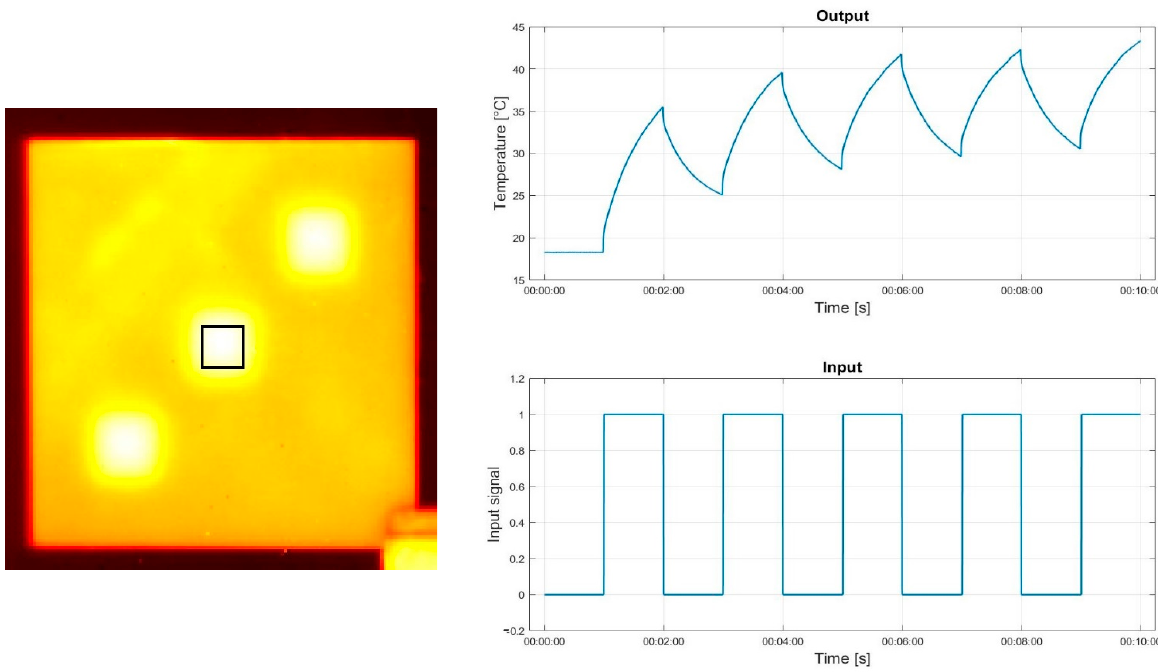
Figure 3. Halogen lamp input and output signal.